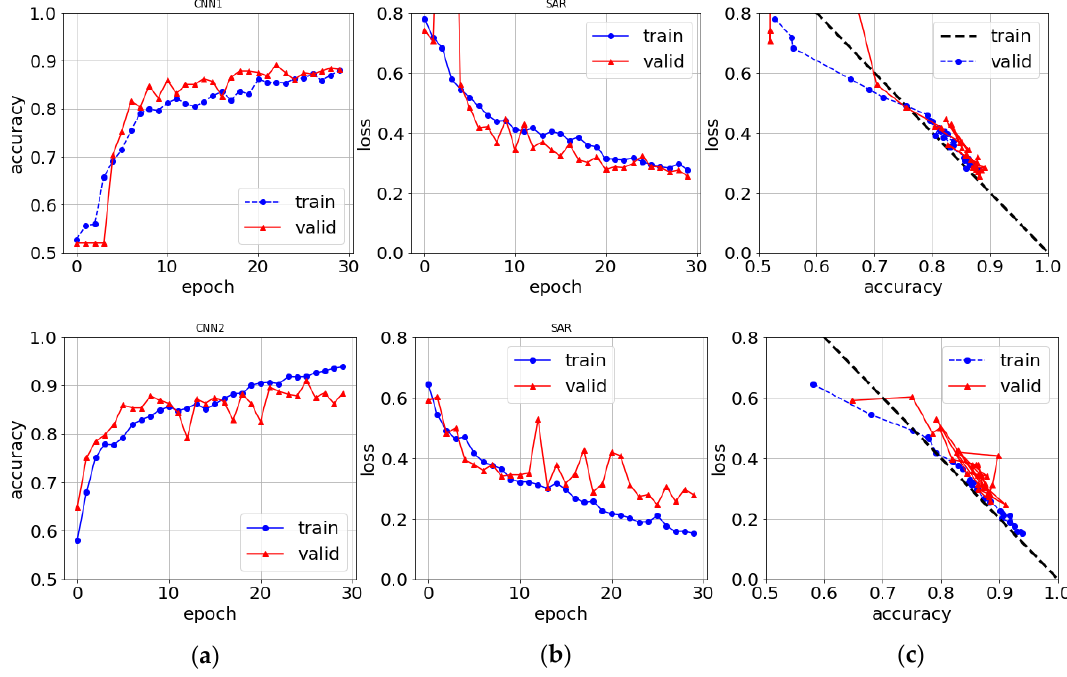
Figure 9. CNN1 top and CNN2 bottom row for the SAR dataset. ( a ) Accuracy and ( b ) Log-loss vs. epochs. ( c ) Log-loss vs. accuracy. The dashed curve is Equation. (6)—see text.